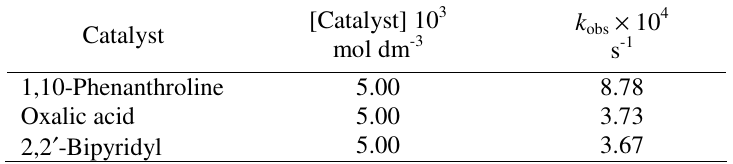
Table 3. Effect of different catalyst on reaction rates *